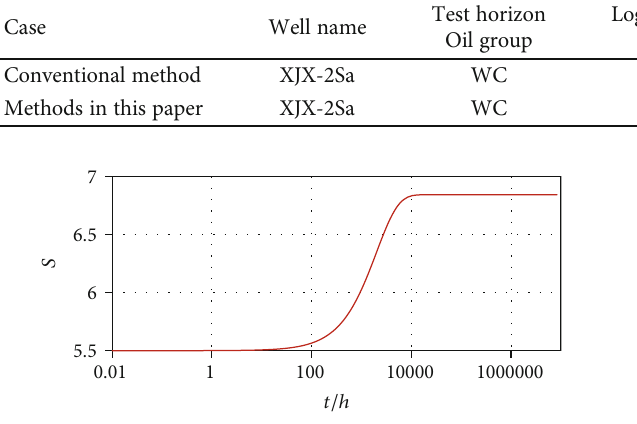
Figure 18: Relationship between skin and invasion time in mud invasion process.